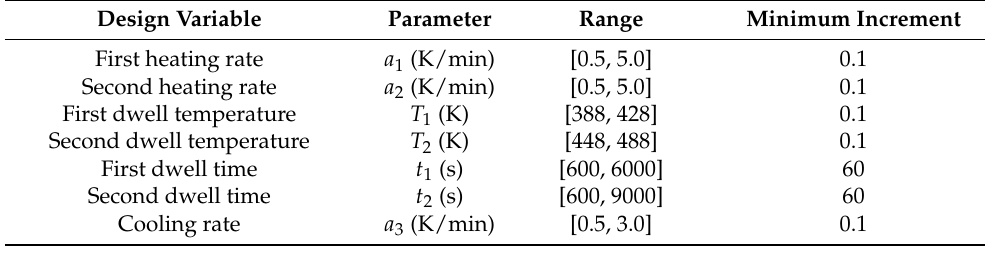
Table 5. Range of the design variable.